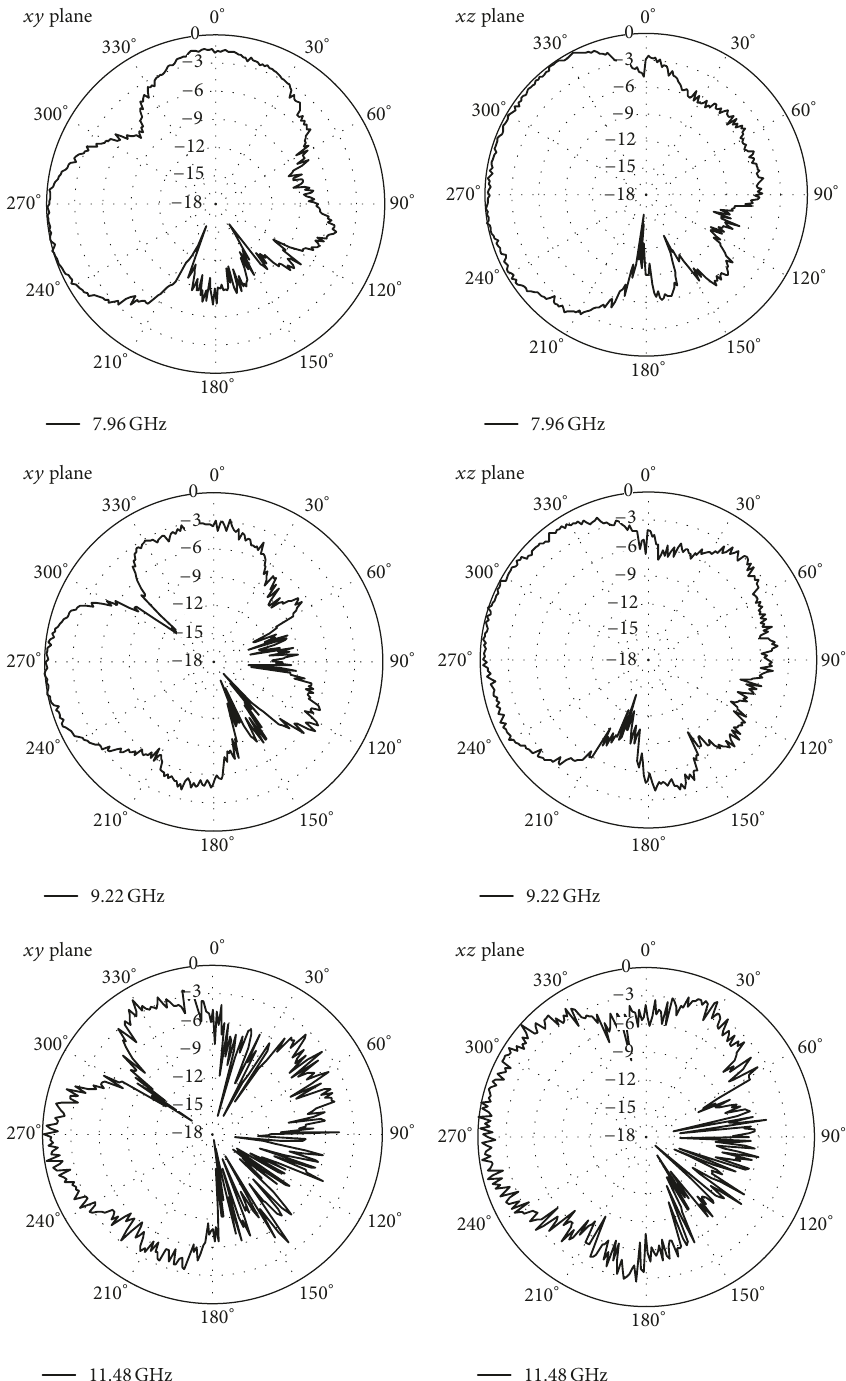
Figure 9: The radiation pattern of the proposed antenna at the following frequencies: 7.96 GHz, 9.22 GHz, and 11.48 GHz in the “ 𝑥𝑦 ” and “ 𝑥𝑧 ”